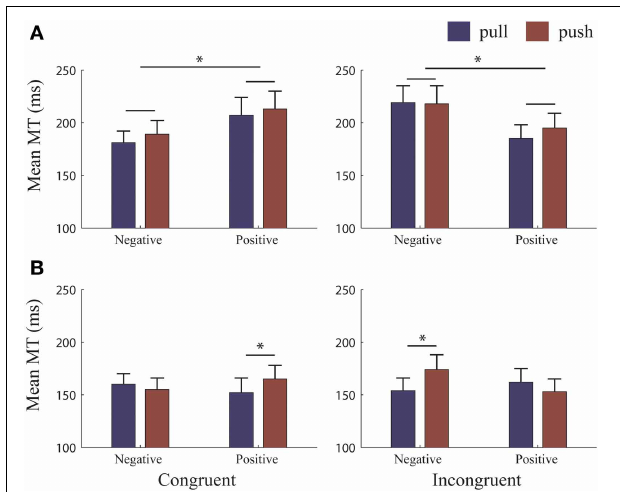
FIGURE 4 | MTs for each reference condition. Mean movement times (MTs) for each reference-frame. (A) Object-reference condition: MTs did not differ when pulling or pushing to approach and avoid albeit MT to avoid were faster than to approach both valences. (B) Self-reference condition: MTs were significantly faster for pulling to approach both positive and negative pictures. There were no significant differences in MT to approach or avoid both valences. Error bars ( + 1 SE); blue bars, pull; brown bars, push. ∗ , significant at > 0.001